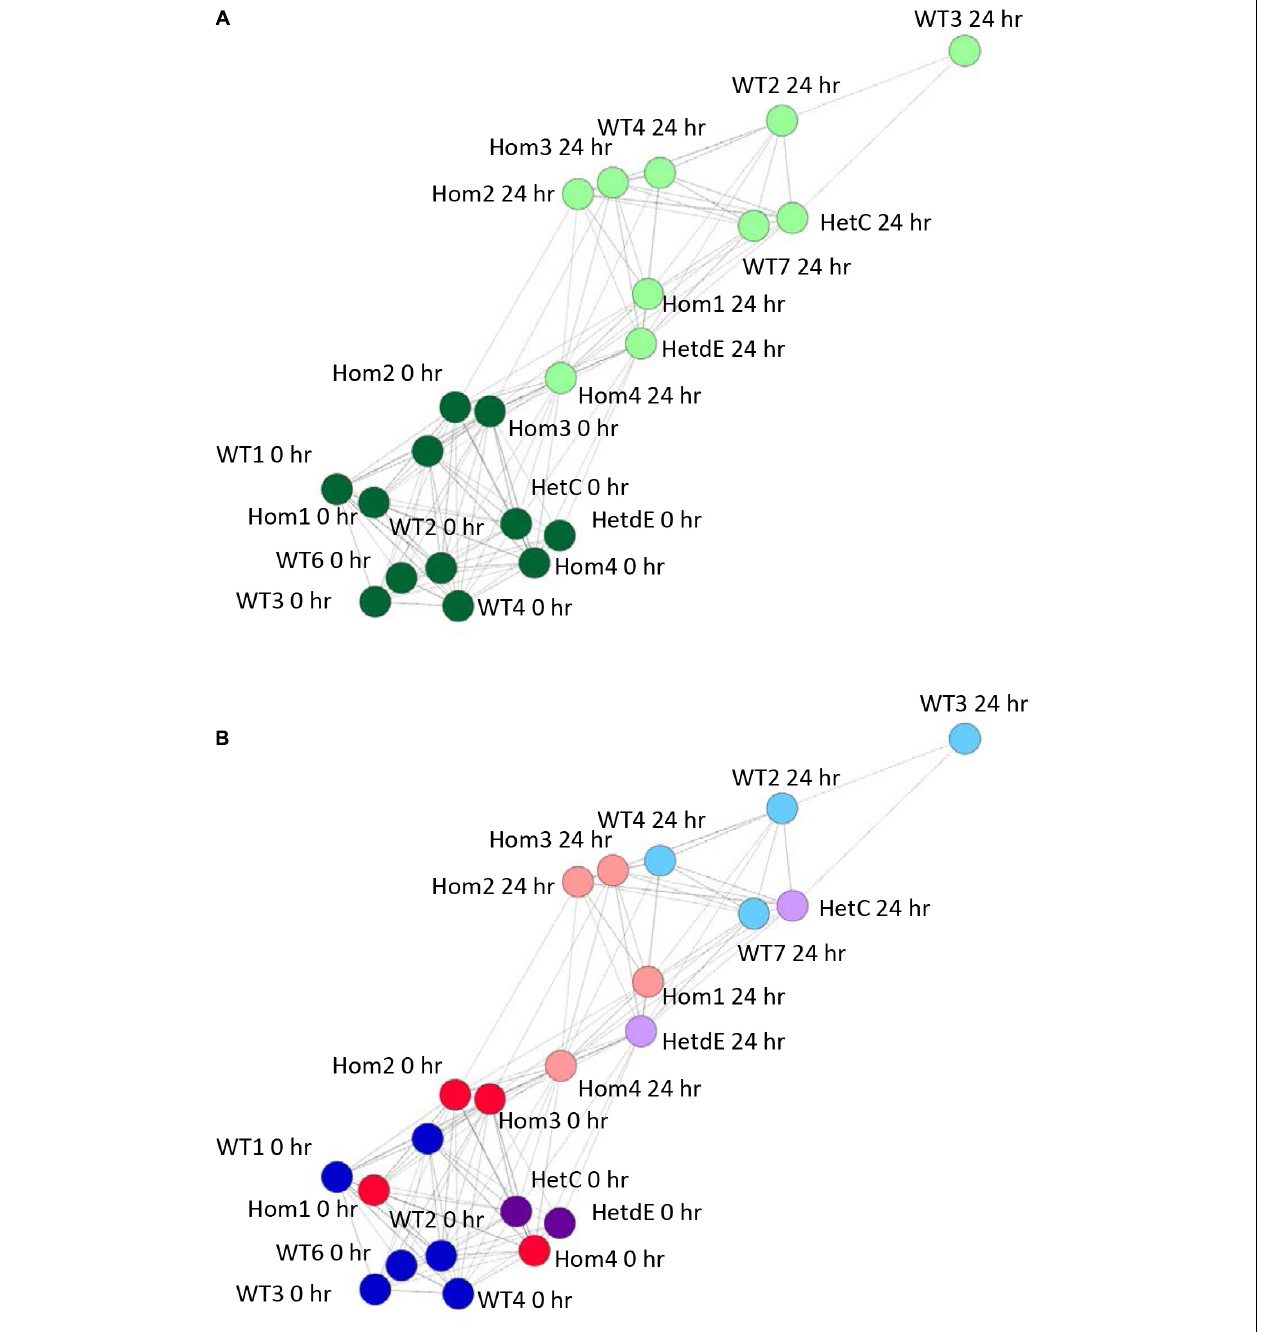
FIGURE 4 | Sample to sample network graph of edited clones. Circles represent clones and lines between them correlations of at least 0.88. Wild type results are from Gazova et al. (2020). (A) Analysis showing the transition from 0 h (dark green) to 24 h post PMA treatment (light green). (B) The same network as in panel (A) , colored to show the effect of genotype on the transition following PMA treatment. Dark colors show cells prior to treatment, light colors show cells 24 h after PMA treatment. Red – homozygotes; purple – heterozygotes; blue – wild type.